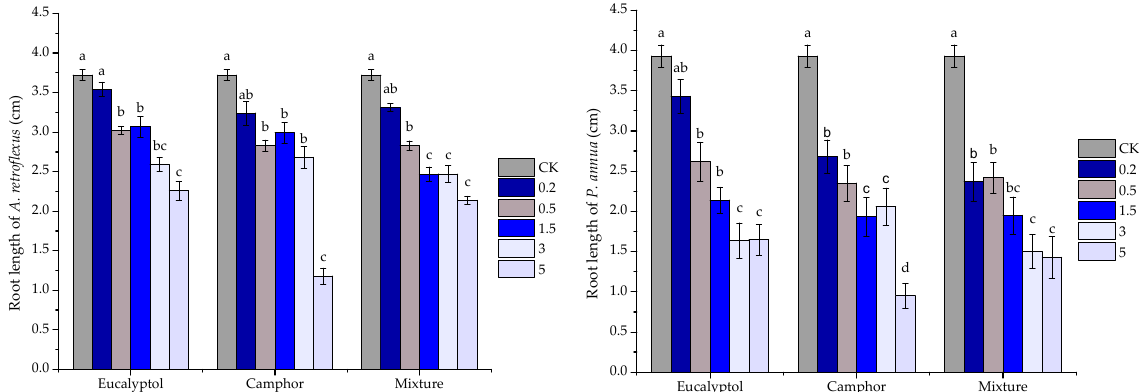
Figure 3. Phytotoxic effect of stem, leaf, flower and flowering shoot volatile oils of S. kaschgaricum on shoot development of A. retroflexus and P. annua . Each value is the mean of five replicates ± SE (n = 50). Different lowercase letters (a, b, c, etc.) indicate significant differences among different concentrations (0 mg/mL(CK), 0.2 mg/mL, 0.5 mg/mL, 1.5 mg/mL, 3 mg/mL and 5 mg/mL) of the same oil treatments at p < 0.05 level according to Fisher’s LSD test, and different uppercase letters (A, B, C, etc.) indicate significant differences among stem, leaf, flower and flowering shoot volatile oils at the same concentration (Fisher’s LSD test, n = 50, p < 0.05).